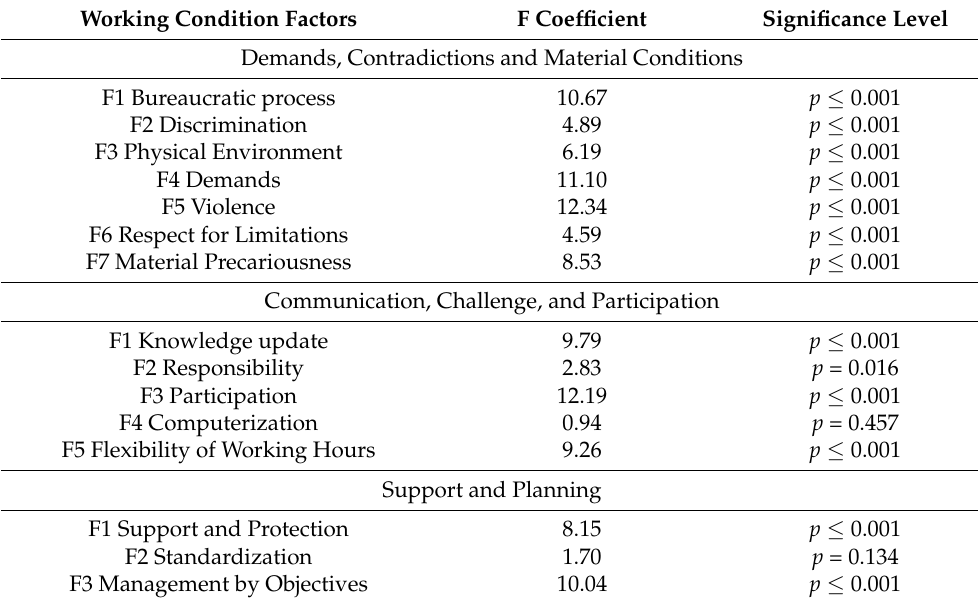
Table 3. Analysis of the empiric factors of working conditions by mental health